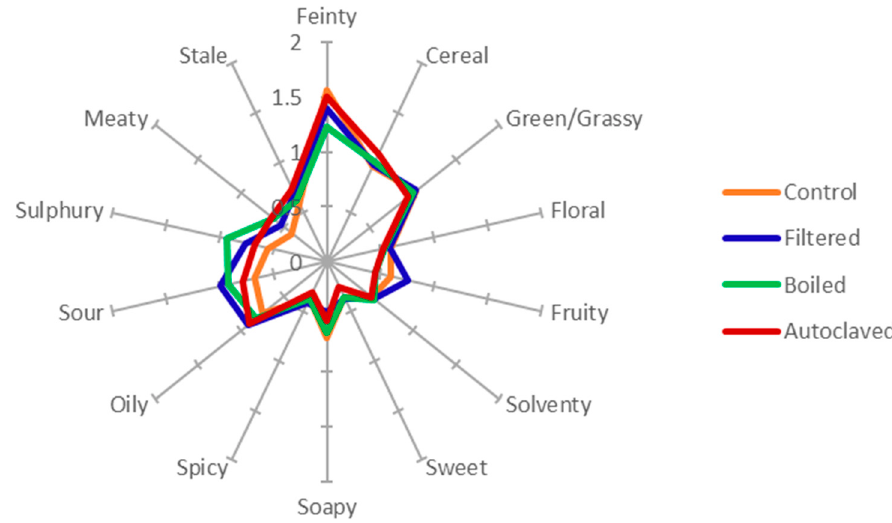
Figure 4. Spider diagram of the QDA mean panel scores for spirits of four pretreatment conditions for wort.